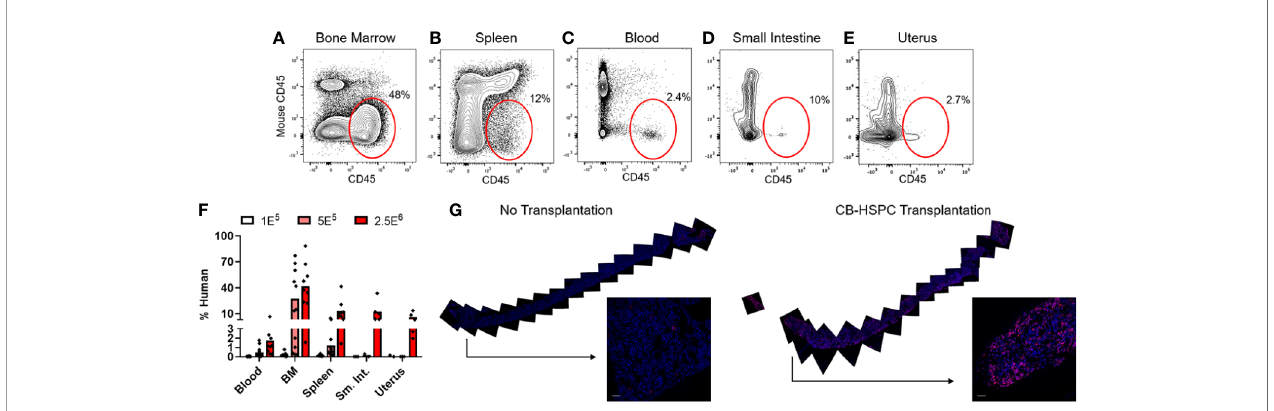
FIGURE 2 | Transplantation of HSPCs is associated with colonization of bone marrow and peripheral tissues by human cells. Bone marrow and peripheral tissues (spleen, blood, small intestine, and uterus) were collected at 12 weeks post-transplantation from mice given varying doses of BM-HSPCs (1E 5 , 5E 5 , 2.5E 6 ). (A – E) Representative plots showing fl ow cytometric staining of human cells (red oval gates) in a mouse transplanted with 2.5E 6 BM-HSPCs. (F) Aggregated data showing percentages of human cells within the total (human CD45 + + murine CD45 + ) hematopoietic compartment from the indicated tissues of mice engrafted with the indicated BM-HSPC doses. Symbols show results from individual mice, bars represent the arithmetic means. (G) Cells expressing human CD45 were detected by immuno fl uorescence of whole bone tissue collected at 12 weeks post-transplant from a mouse given 2.5E 6 CB-HSPCs (right side), compared to a negative control unengrafted mouse (left side). Staining of human CD45 is shown in red; blue color shows staining of cell nuclei by DAPI.